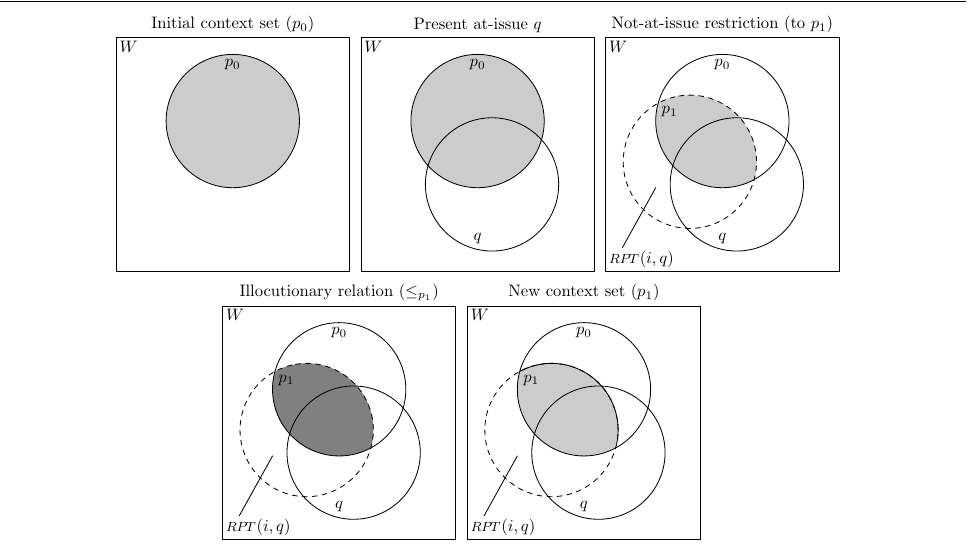
Figure 3 Updates for ( 14 ): Cheyenne reportative